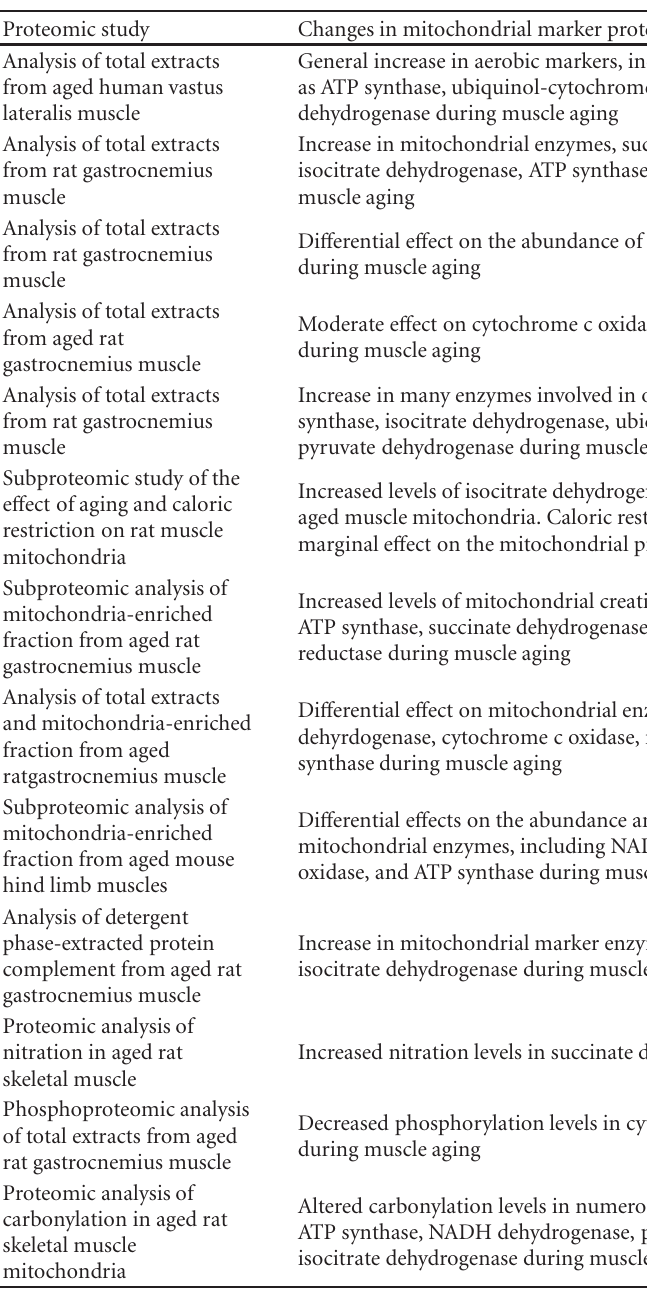
Table 2: Proteomic identification of mitochondrial proteins during skeletal muscle